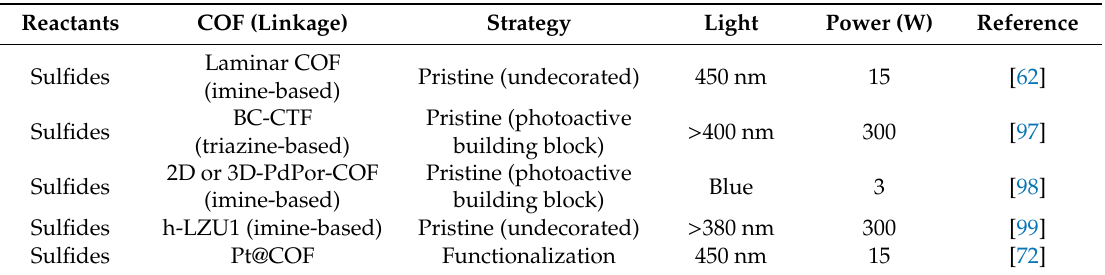
Table 4. Photosulfoxidation reactions mediated by COFs.